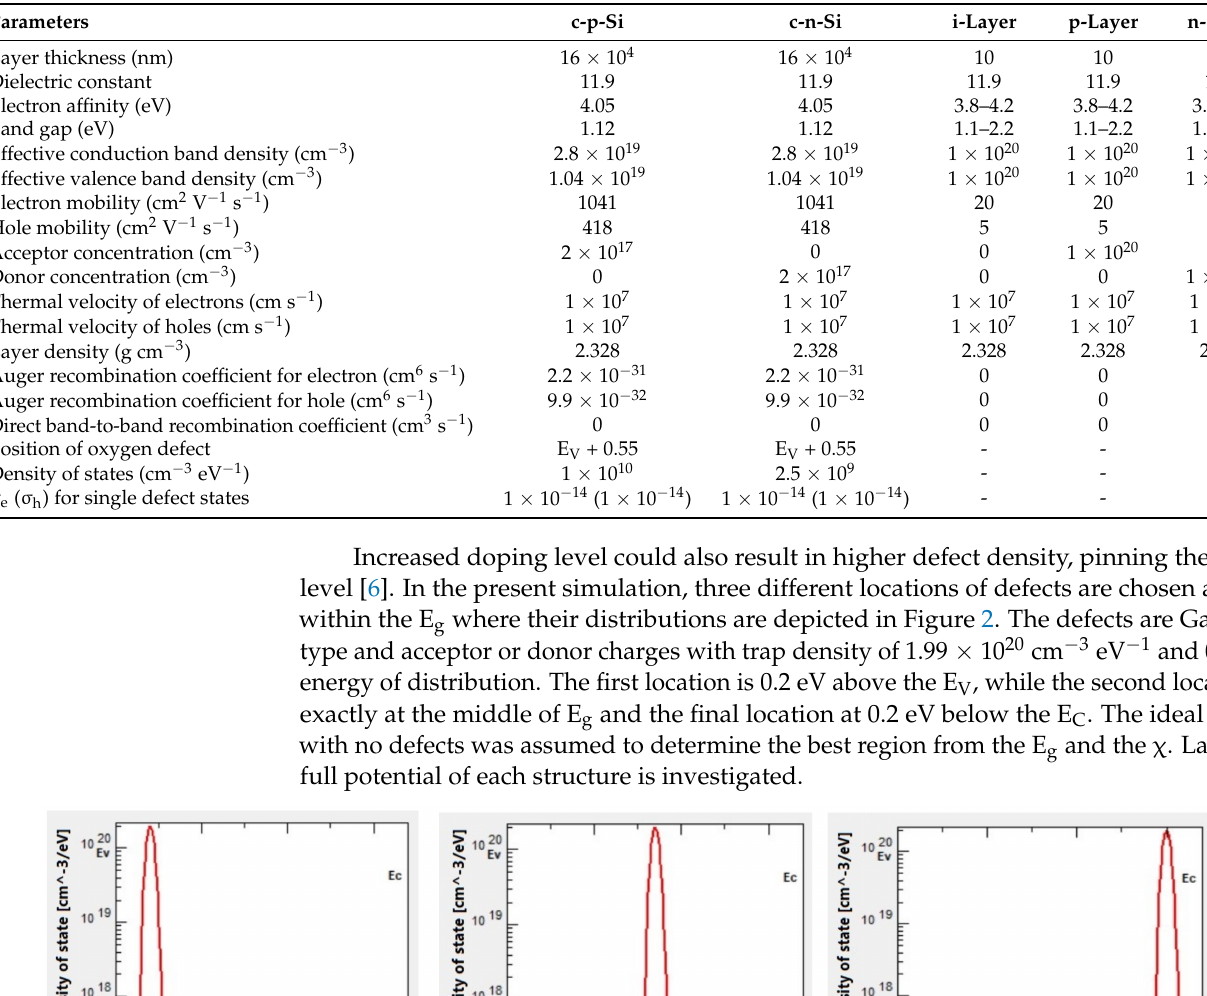
Table 1. Parameters used in the simulation.